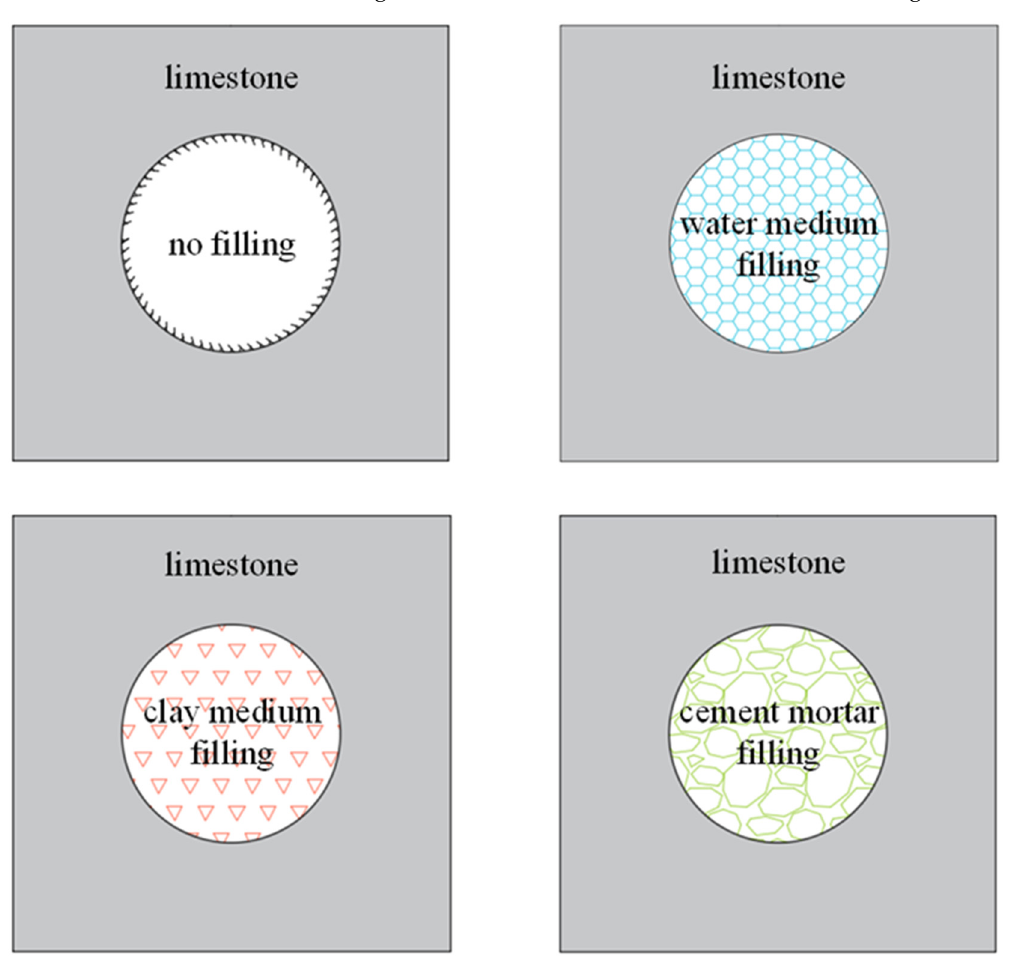
Figure 8. Schematic diagram of calculation conditions.